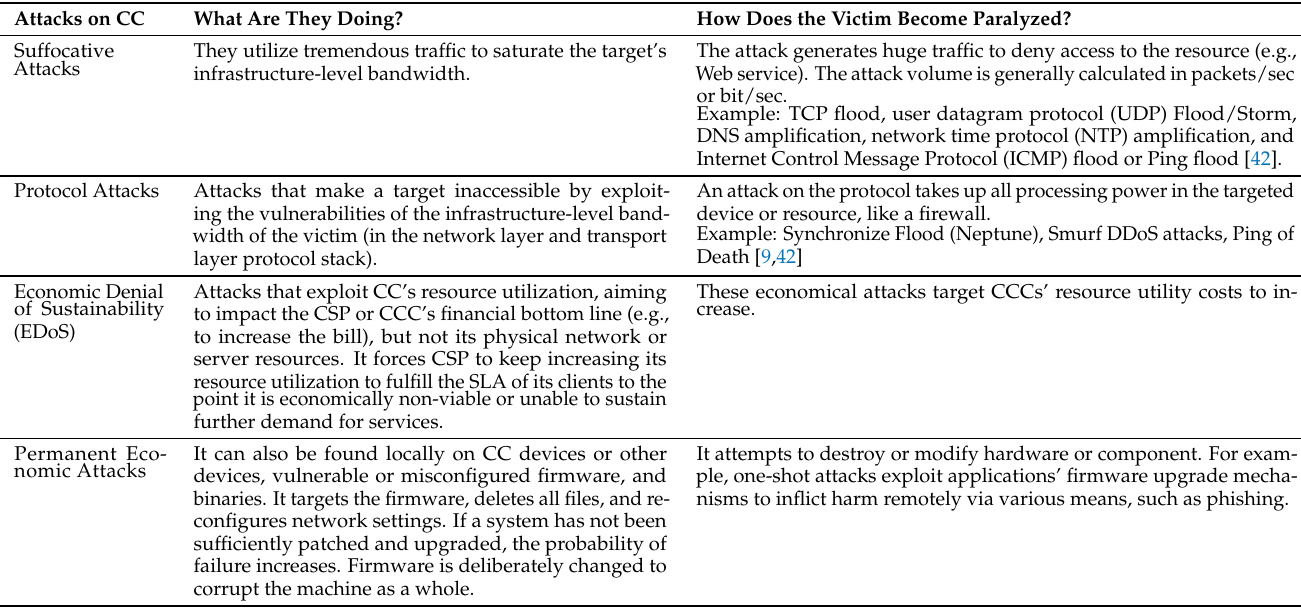
Table 4. Attacks on CC based on two